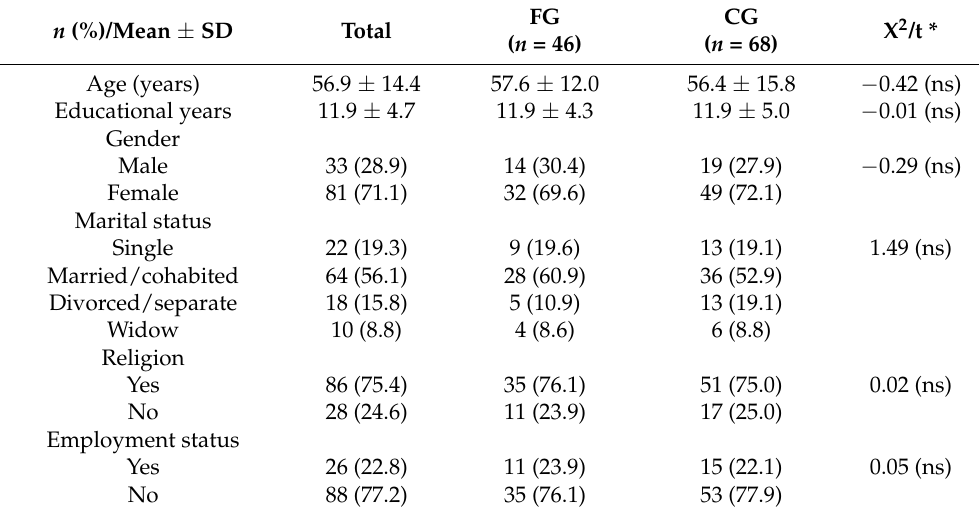
Table 1. Participant profile (N = 114).